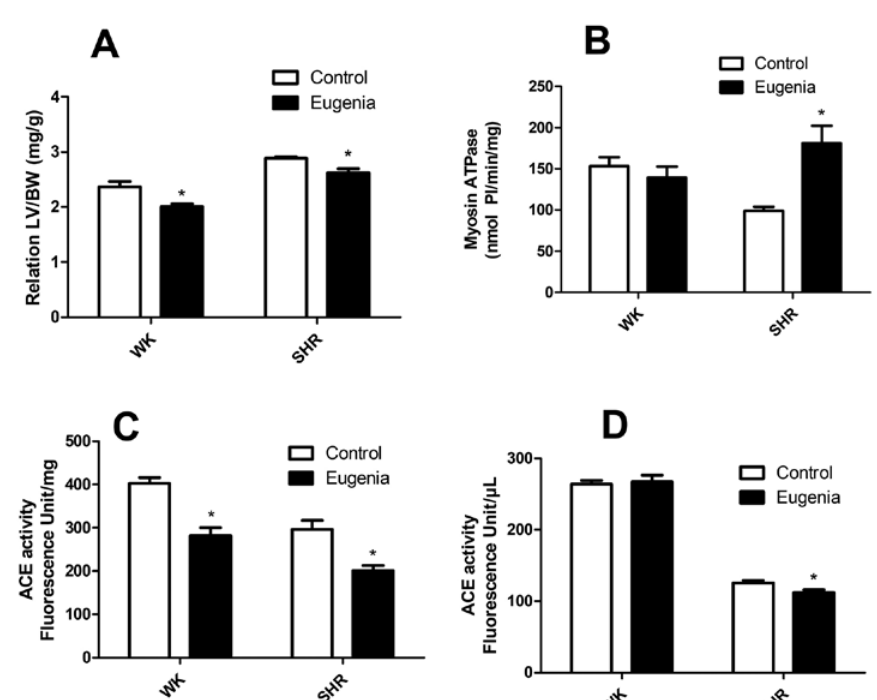
FIGURE 2 - Evaluation of the cardiac hypertrophy index and biochemical evaluations in rats treated for 30 days with the essential oil of the leaves of Eugenia sulcata (10 mg/kg). Legend: (A) LV cardiac hypertrophic index. Left Ventricular Weight/Body Weight (LV/BW) (B) Myosin ATPase activity in LV myosin preparations. (C) Serum angiotensin converting enzyme activity (ACE). (D) Activity of the ACE in the LV homogenate. * p<0.05 vs Control and # p<0.05 vs WK Control. Student’s